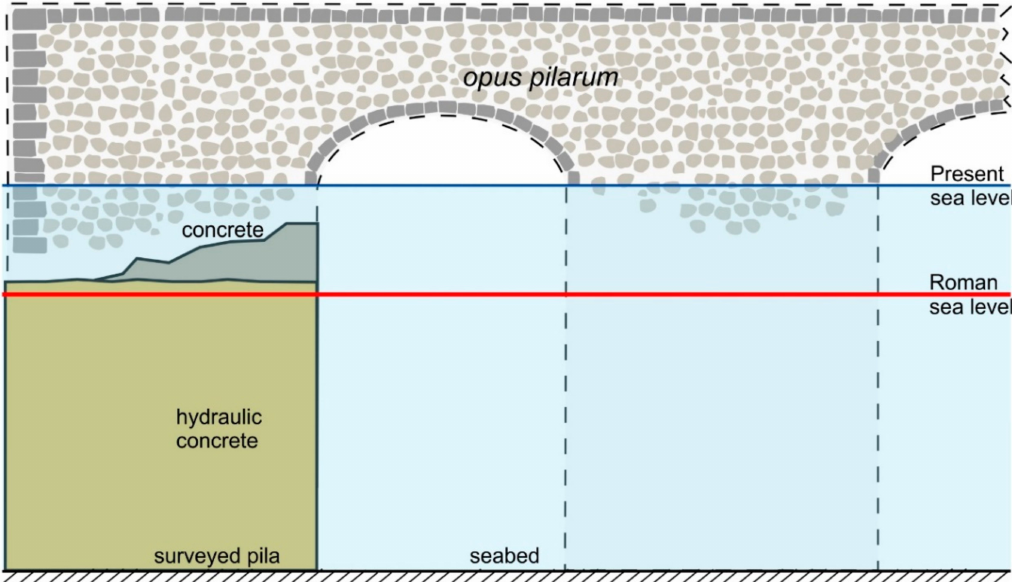
Figure 24. Roman sea level position and pictorial reconstruction of the Nisida opus pilarum . The surveyed pila is drawn in continuous black line. The structures drawn in dashed line were reconstructed from the historical maps in Figure